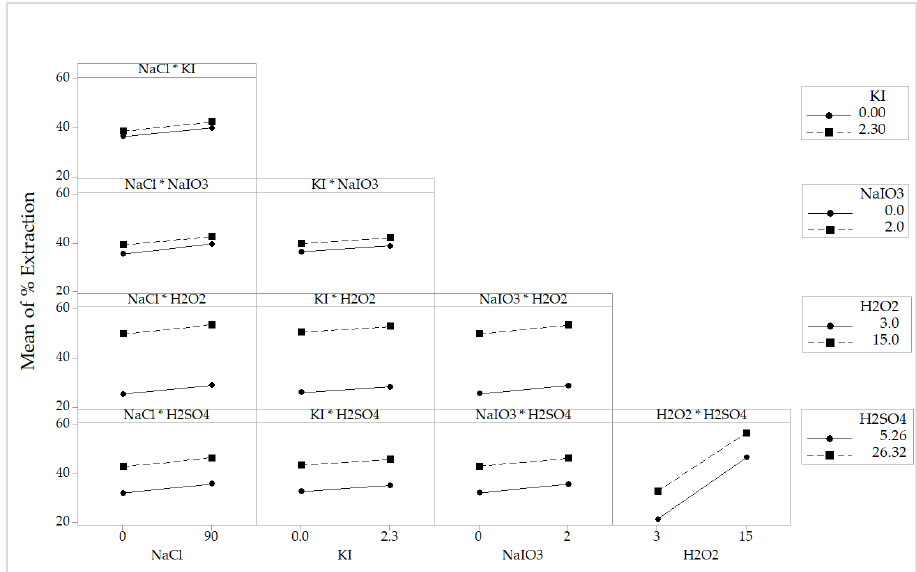
Figure 4. Interaction plot.